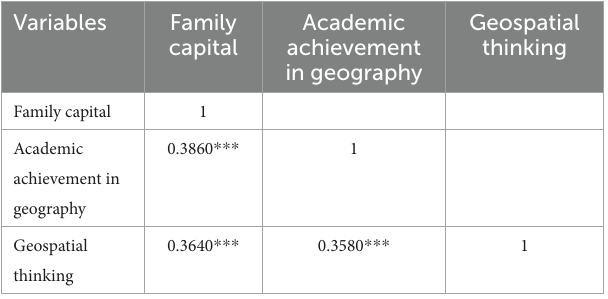
TABLE 2 Pearson’s r for the three